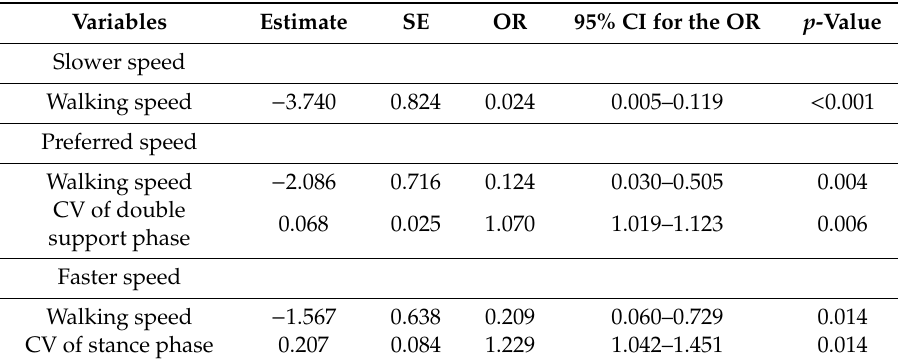
Table 4. Binary logistic regression results for insomnia and control